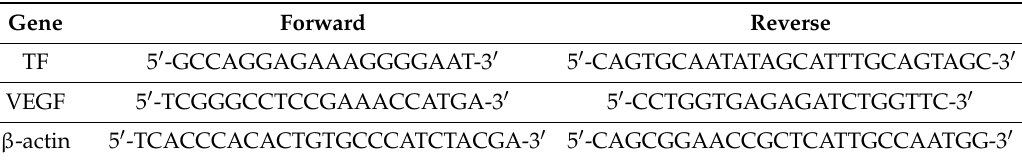
Table 1. Specific primer sequences used for real-time PCR